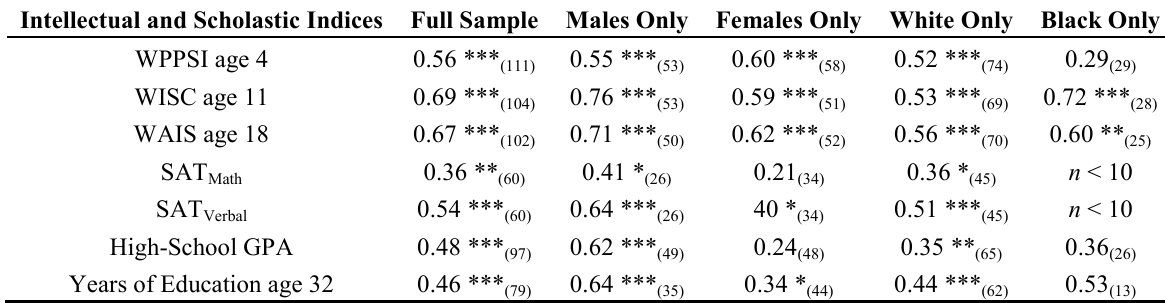
Table 1. Bivariate correlations between “high intellectual capacity” ratings judged at ages 3–4 and indices of intellectual ability and scholastic